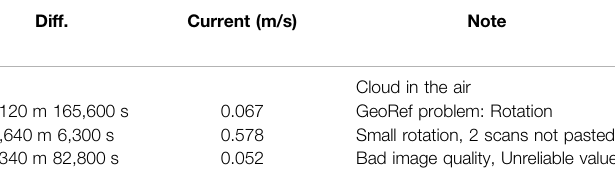
TABLE 1 | Satellite images